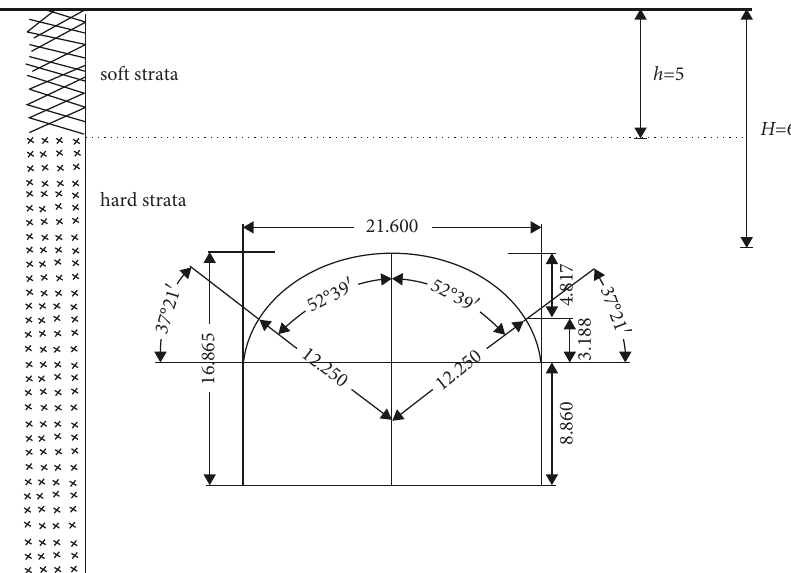
Figure 3: Cross section of the metro tunnel.